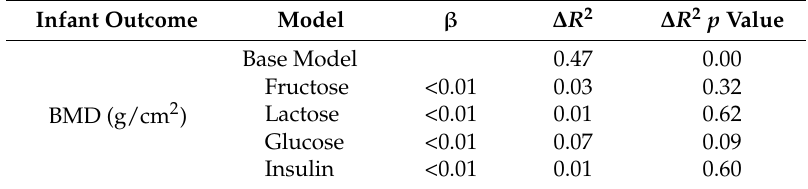
Table 3. Relationships between breast milk sugars and infant body composition at 6 months of age a . Infant Outcome